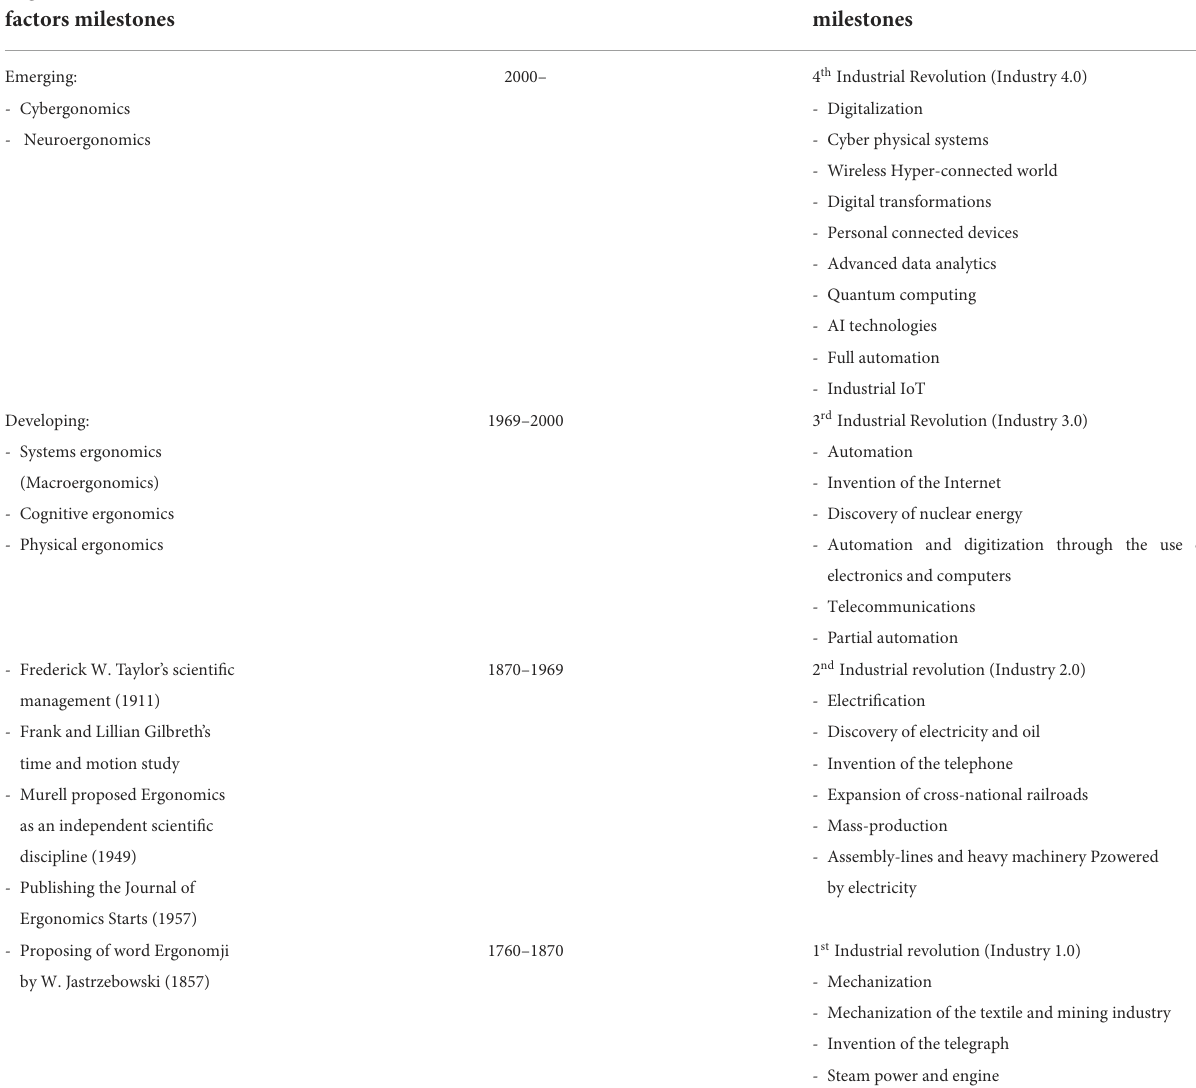
TABLE 2 Some milestones of industrial revolutions and